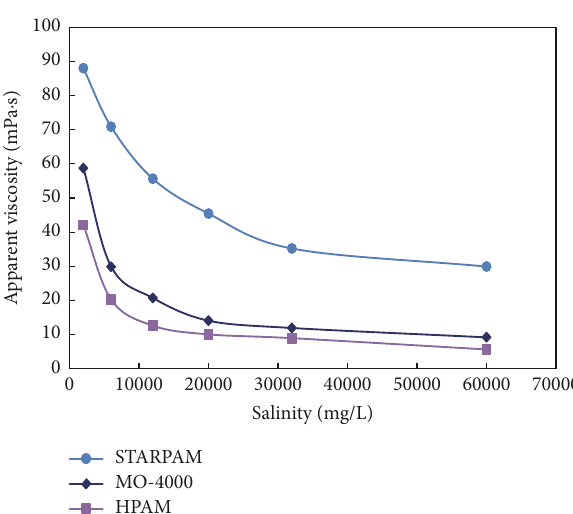
Figure 3: Comparison of heat resistance.